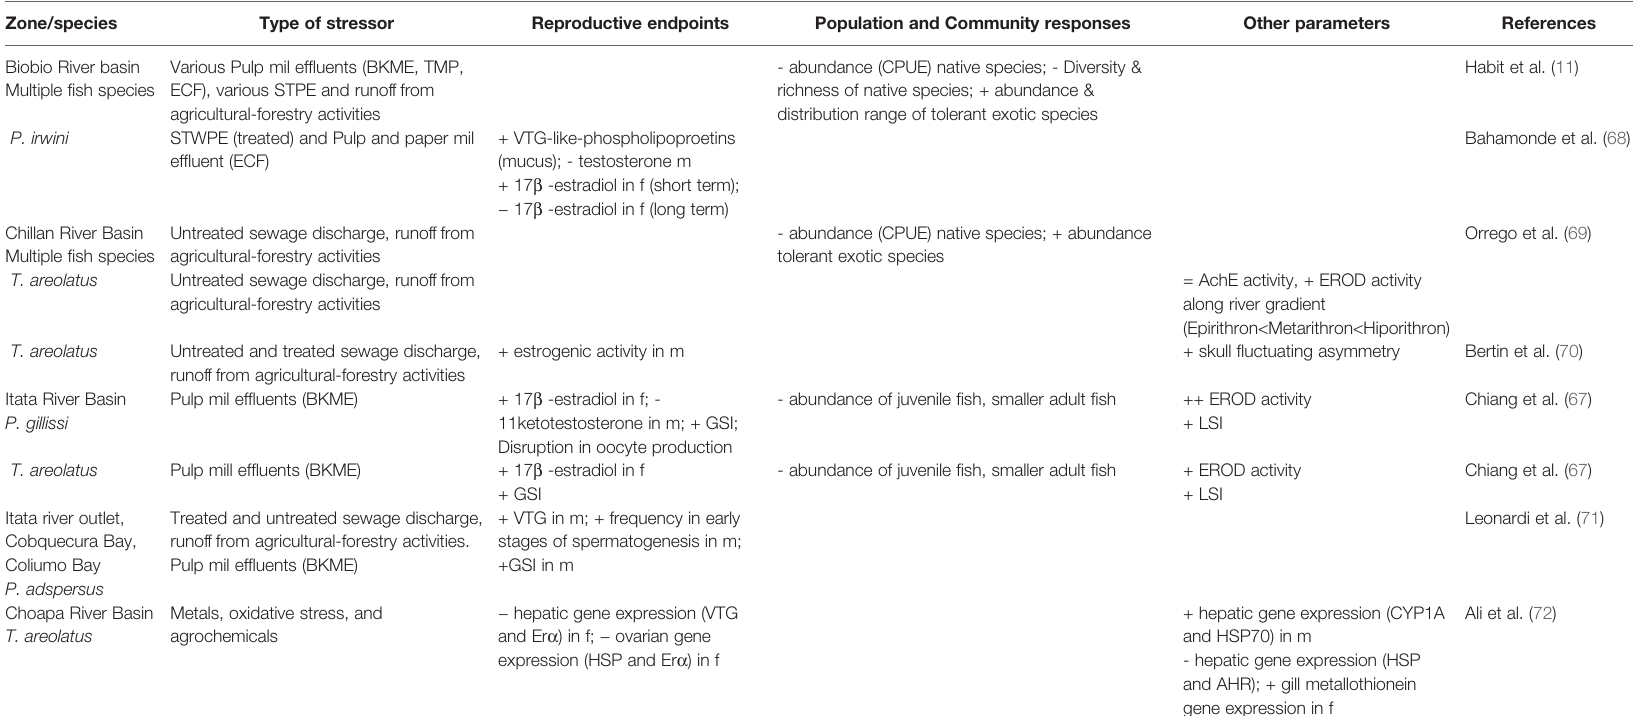
TABLE 2 | Most relevant biological responses to EDCs and other stressors in native fi sh from